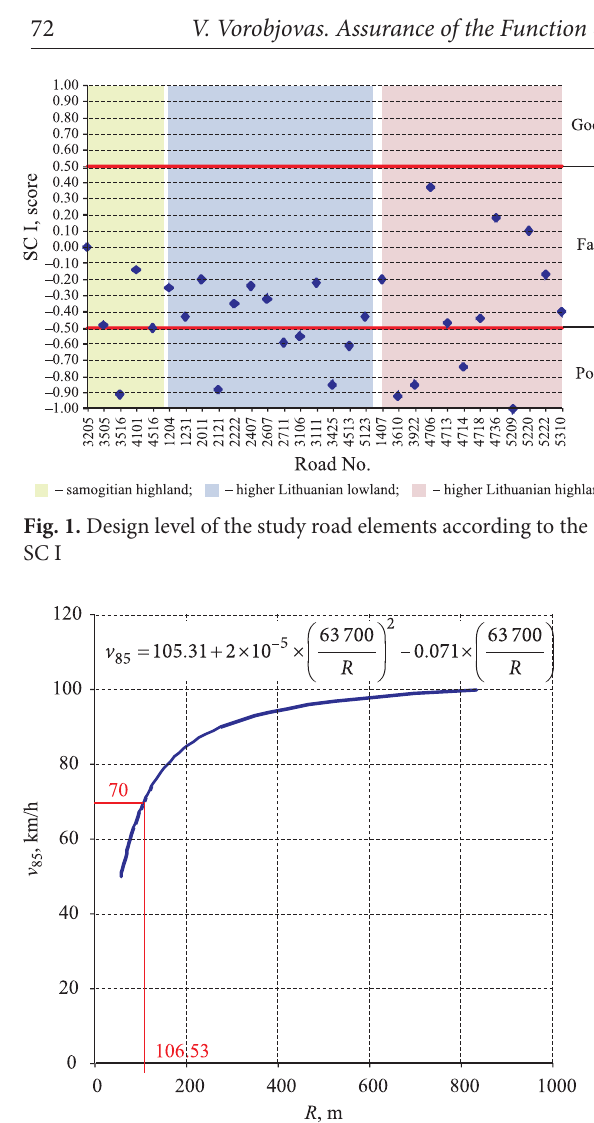
Fig. 2. Dependency of v 85 on R when the design speed v p is 70